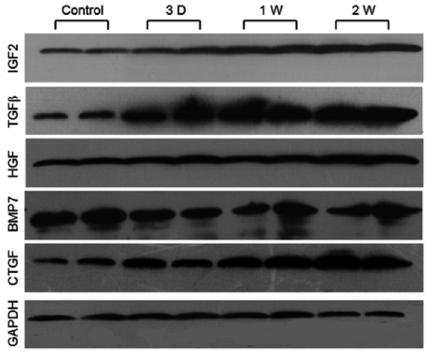
Figure 3. Western blot analysis of abnormal cytokine expression in mice after unilateral ureteral obstruction (UUO). TGF b : transforming growth factor beta; HGF: hepatocyte growth- promoting factor; BMP7: bone morphogenetic protein-7; CTGF: connective tissue growth factor; GAPDH: glyceraldehyde 3- phosphate